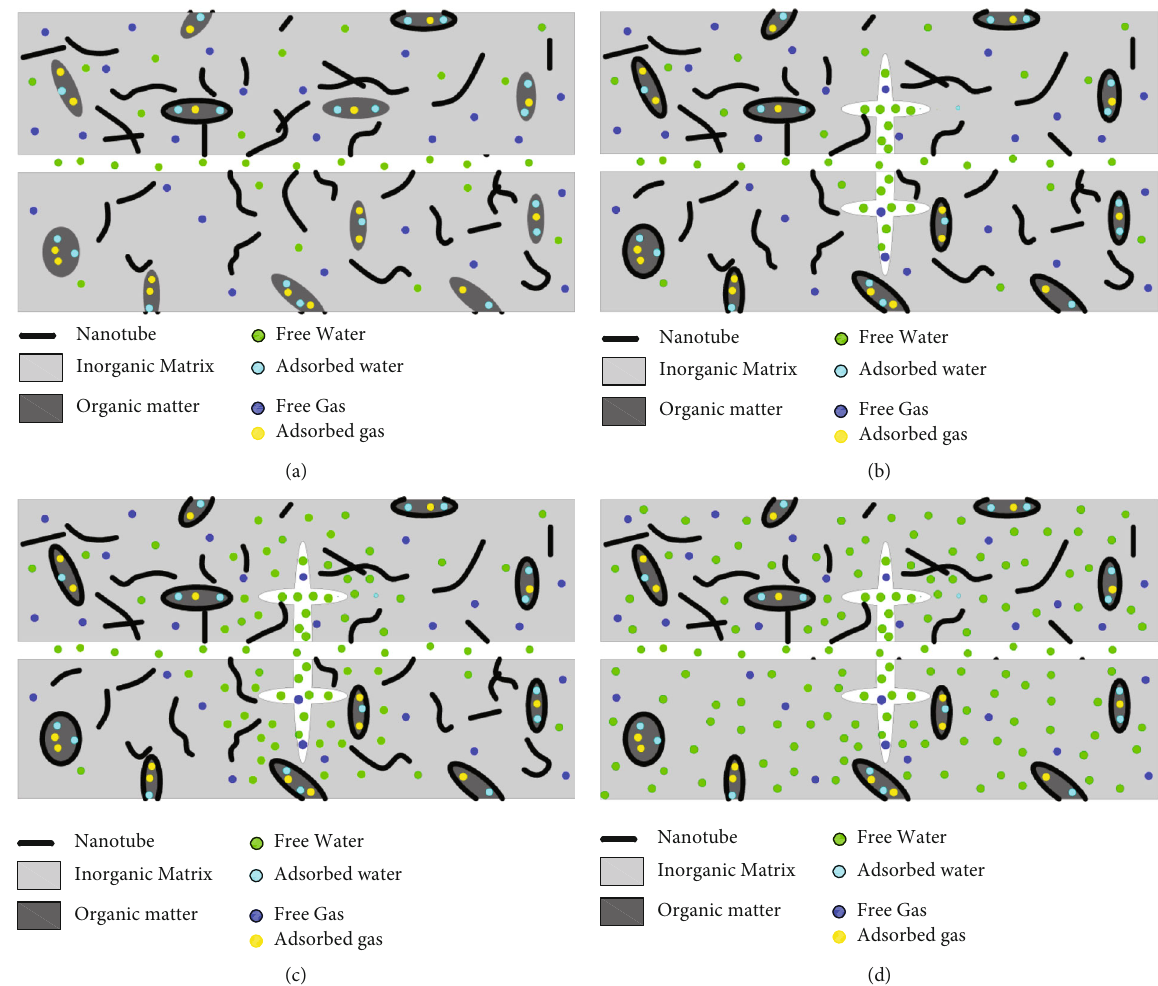
Figure 2: Schematic illustration of the water injection process: (a) initial and pressure rise stages, (b) HF stage, (c) water imbibition stage, and (d) fi nal